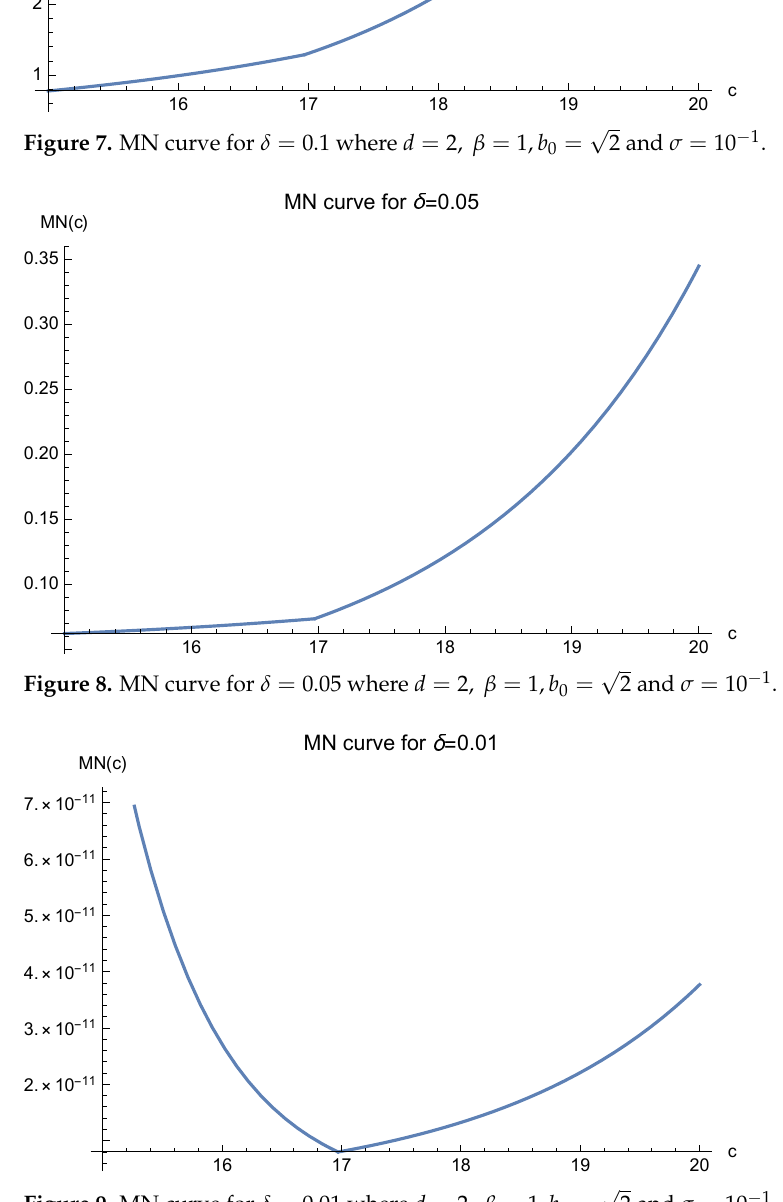
Figure 9. MN curve for δ = 0.01 where d = 2, β = 1, b 0 =